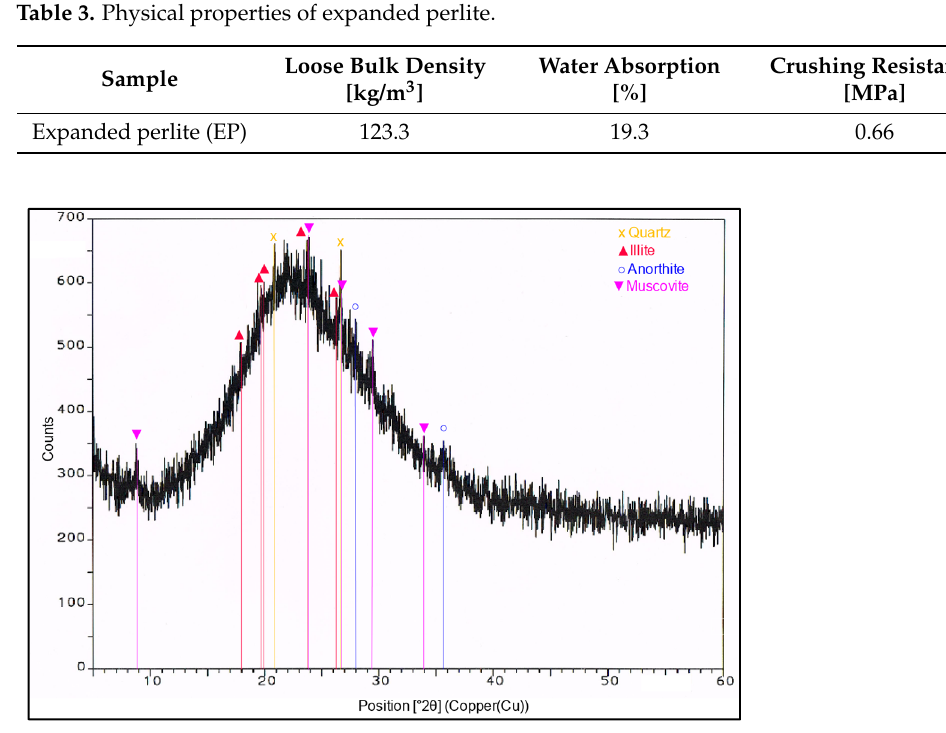
Table 3. Physical properties of expanded perlite.